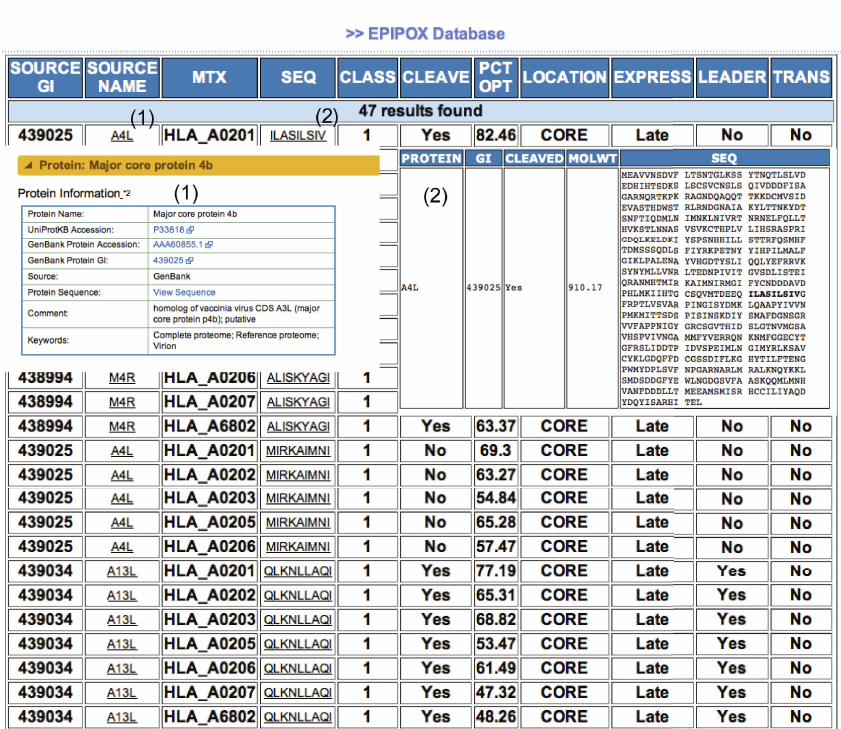
Figure 3: EPIPOX result page. The figure shows a slice of the output resulting from promiscuous CORE protein peptides binding to the A2 supertype. The output consists of a tabulated list, with information on each of the fields of the search query (columns). From field SOURCE NAME (1), users can access proteins from the Virus Pathogen Database (http://www.viprbrc.org/) (1) and by clicking on the epitope sequence, field SEQ (2), users will get the amino acid sequence of the protein showing the peptide in bold